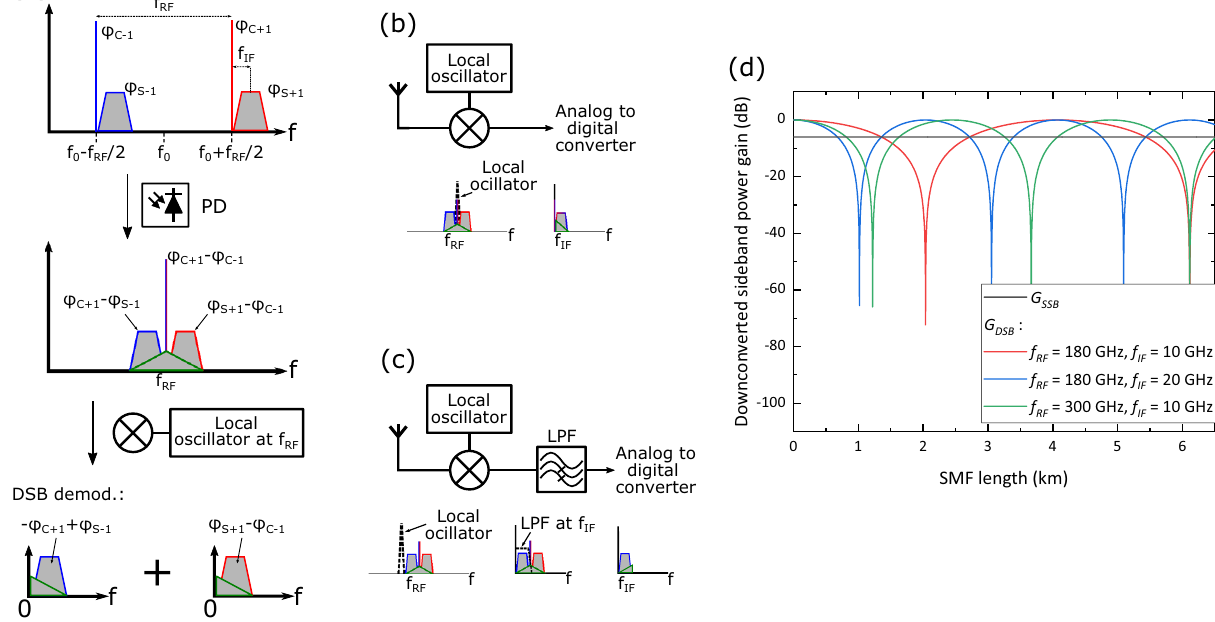
Figure 5. ( a ) Dispersion-induced phase shifts in each of the signals generated in a single-path photonic system with DSB demodulation, ϕ S + 1 , ϕ C + 1 , ϕ S − 1 , and ϕ C − 1 are the phase shifts due to chromatic dispersion of the carriers and sidebands of the two SSB-C optical signals (all phases are relative to that of the pulse center, which has a frequency of f 0 ); ( b ) DSB demodulation receiver; ( c ) SSB demodulation receiver; and ( d ) downconverted sideband power gain versus length of the optical fiber link for the SSB and DSB receivers and various values of f RF and f IF (calculations made with β 2 = − 21.7 ps 2 / km